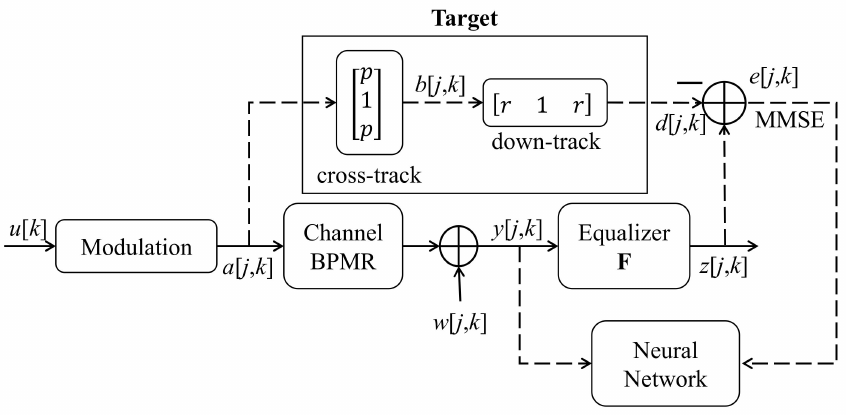
Figure 5. Model for training the neural